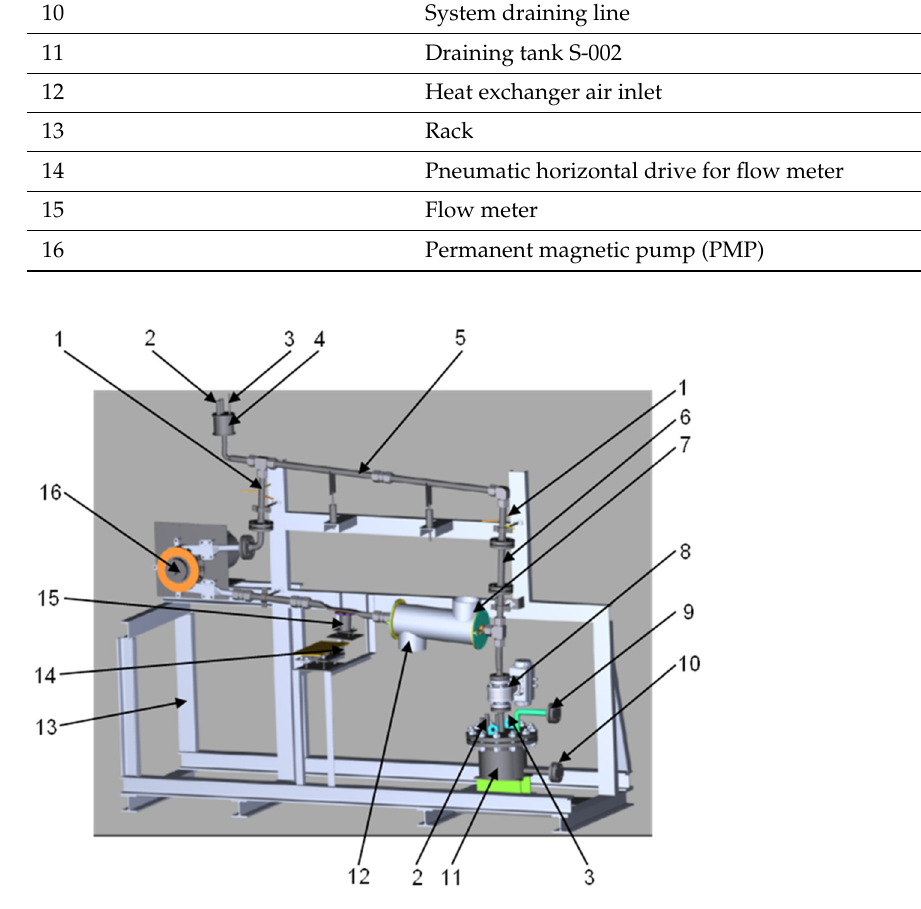
Figure 1. 3D sketch of the CiCLo-C facility. Table 1. Main components of the loop, as indicated in Figure 1.